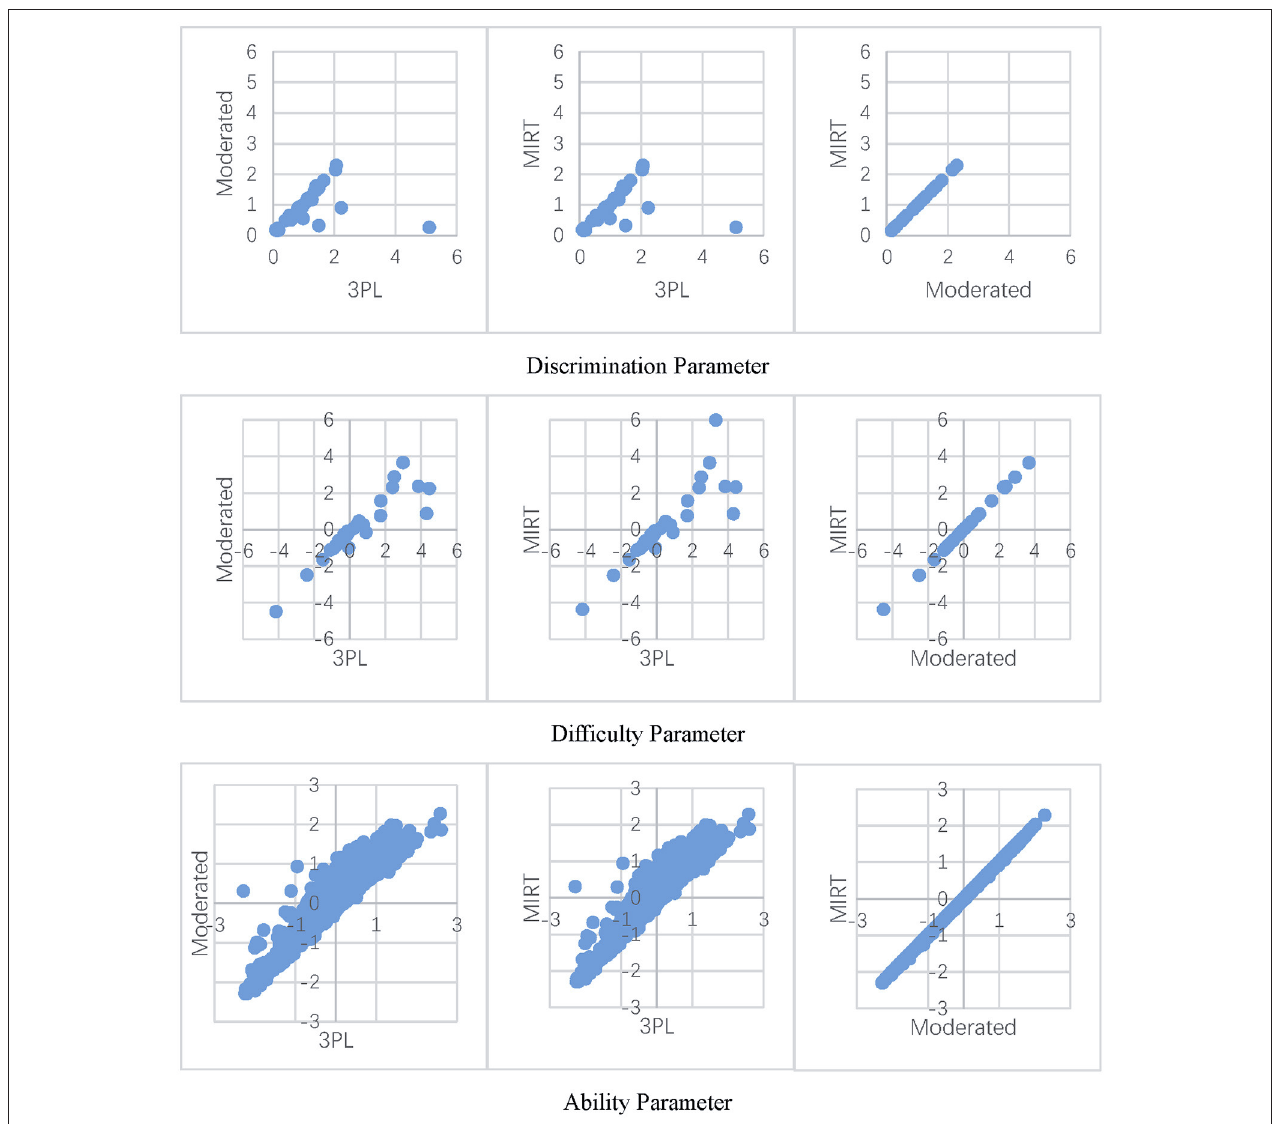
FIGURE 3 | Parameter estimates under Different